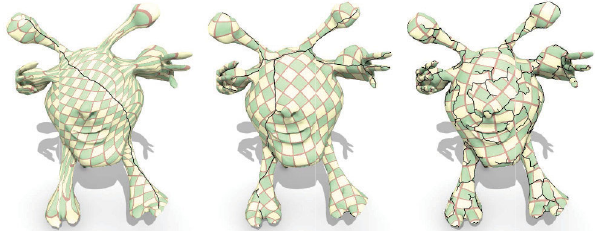
Fig. 12 Cut construction for parameterizations. In general, the longer the cut seam, the smaller the